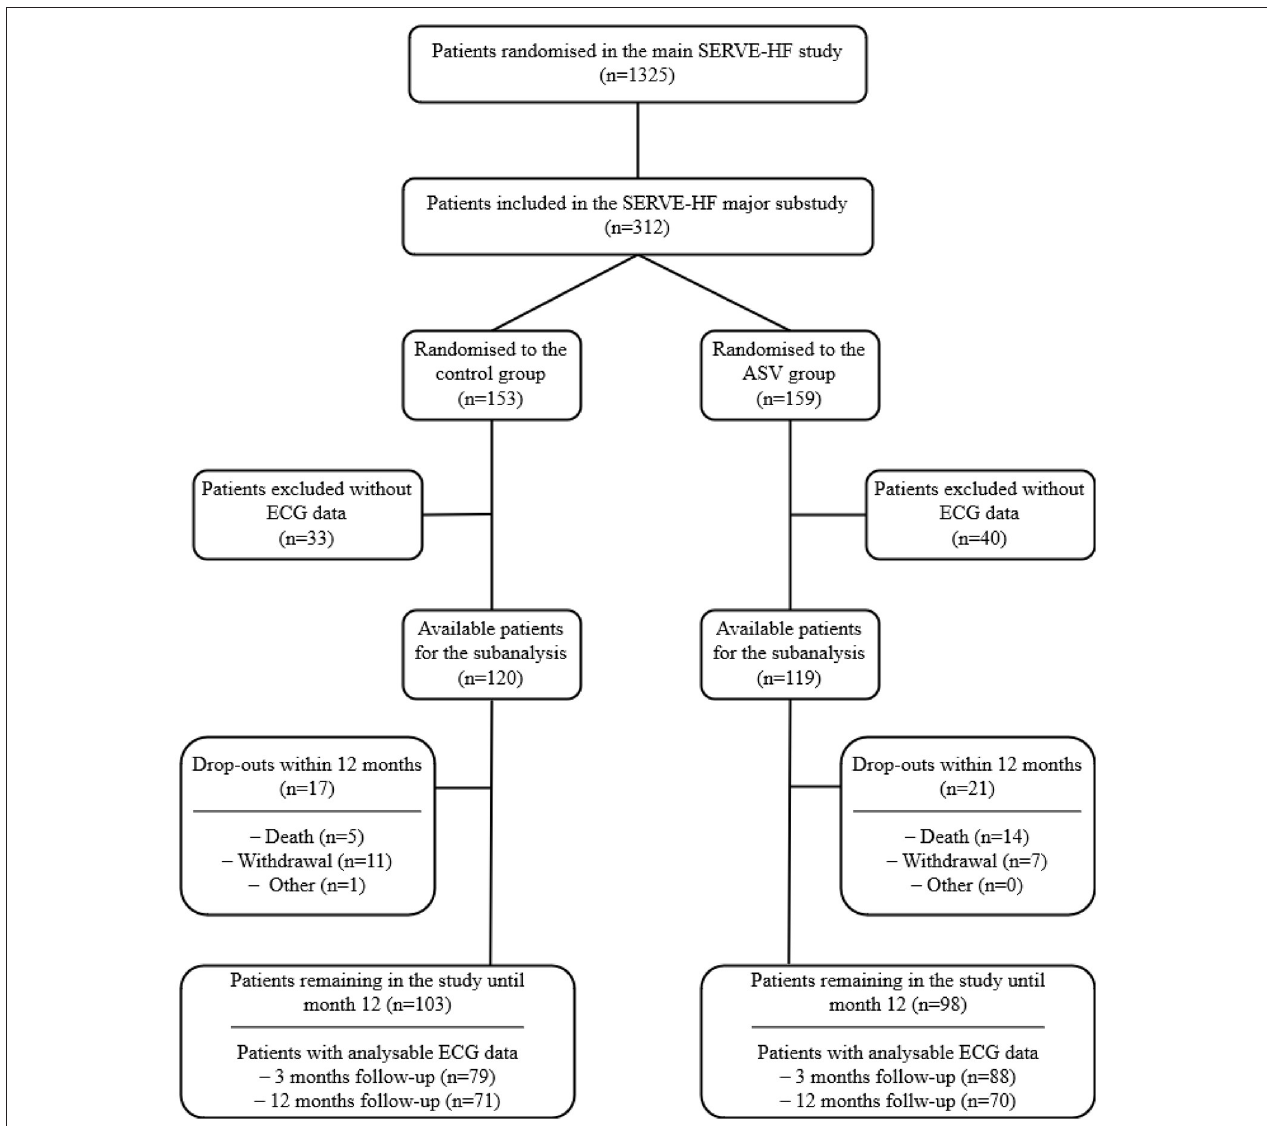
FIGURE 1 | Flowchart for the ancillary analysis of the effects of treatment with adaptive servo-ventilation (ASV) of participants from the SERVE-HF major substudy. ECG, electrocardiogram.